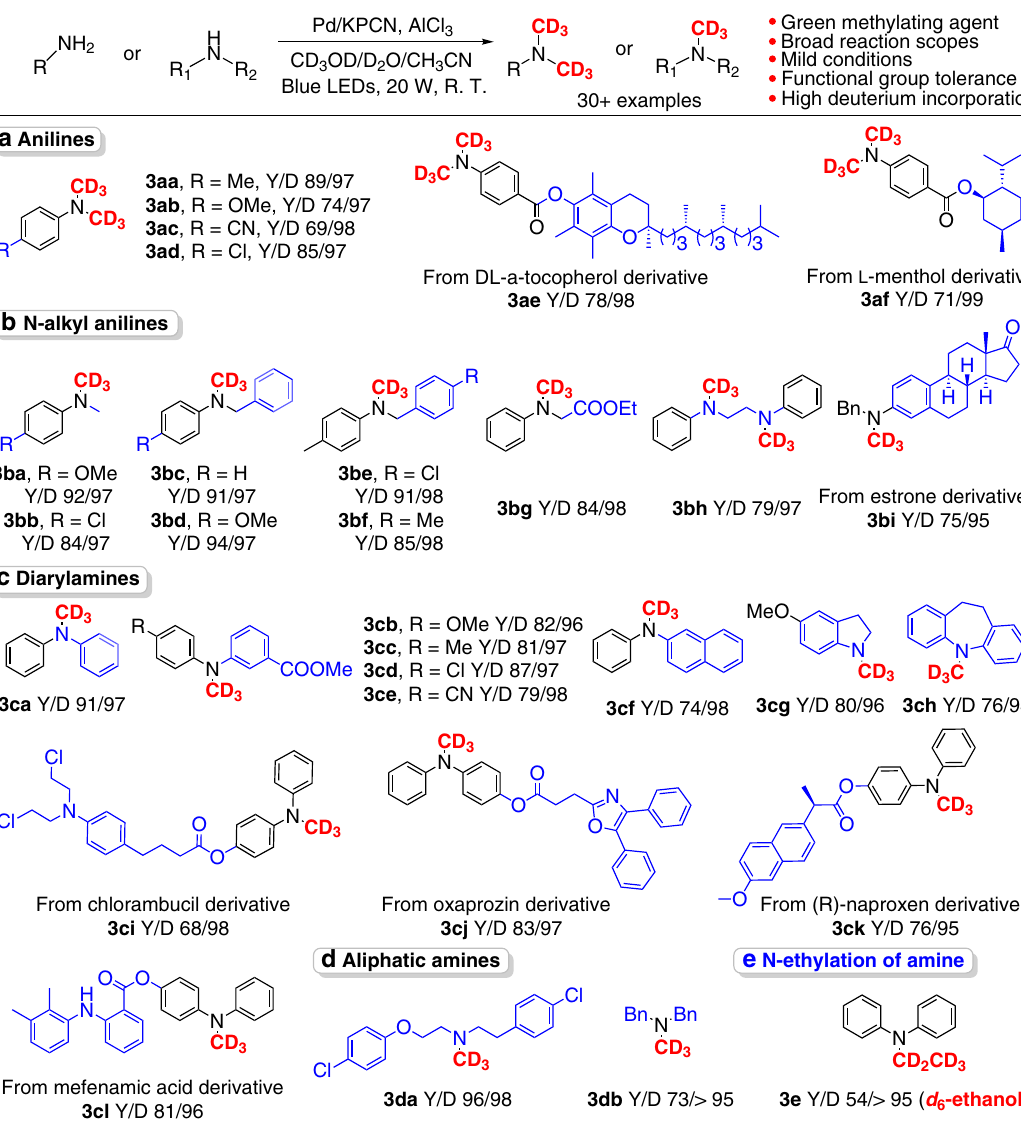
Fig. 3 Substrate scopes of the N -trideuteromethylation of amines. Y represents yield. D represents D-incorporation percentage. Reaction conditions: 0.4 mmol amine, 25 mg of Pd/CPCN, 0.3 mmol AlCl 3, Acetonitrile/D 2 O/CD 3 OD = 2 ml/1.5 ml/1.0 ml, Blue LEDs, 20 W, rt. a Synthesis of deuterated annilines. b Synthesis of deuterated N -alkyl annilines. c Synthesis of deuterated diarylamines. d Synthesis of aliphatic amines. e N -ethylation of